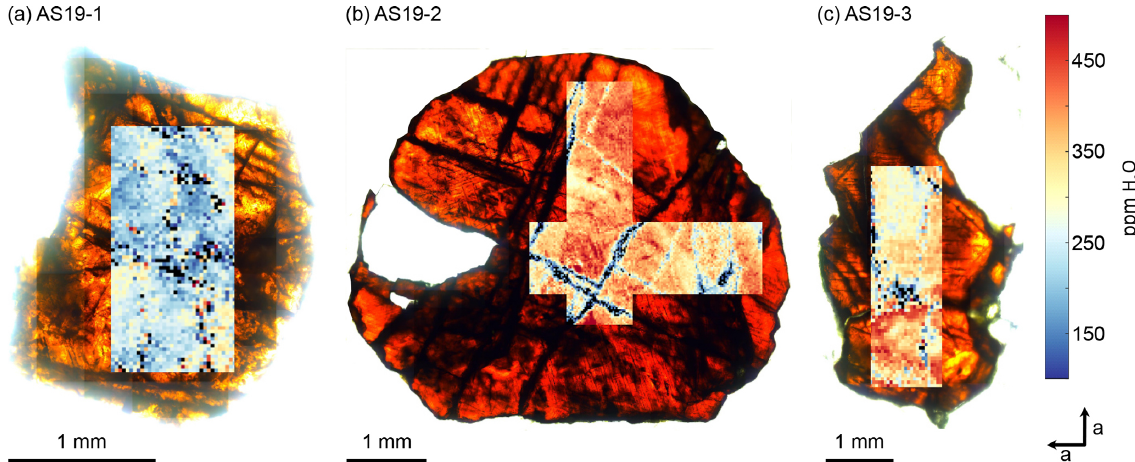
Figure 4. MCT-FTIR maps of samples cut perpendicular to the crystallographic c axis. H 2 O contents have been calculated from the OH range of 3200–3500cm − 1 using Eq. (6). H 2 O maps are superimposed on transmitted-light microscopy images taken during the FTIR